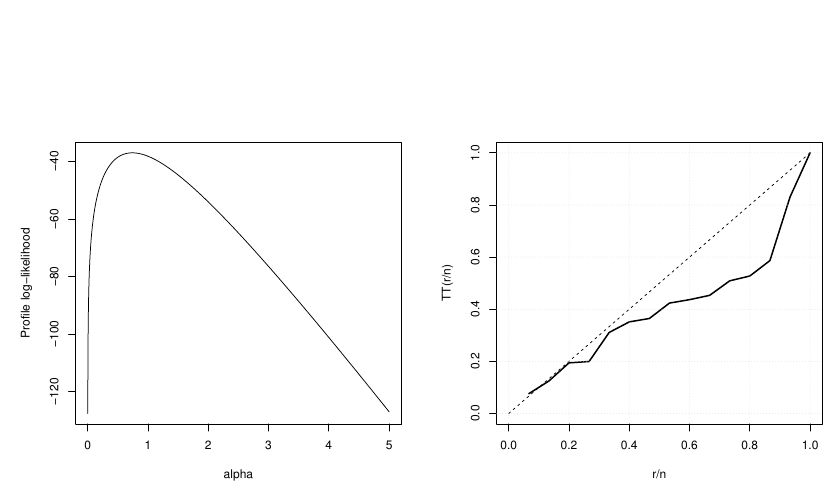
Figure 5 – Profile log-likelihood function of α (left) and TTT plot for the data set (right).